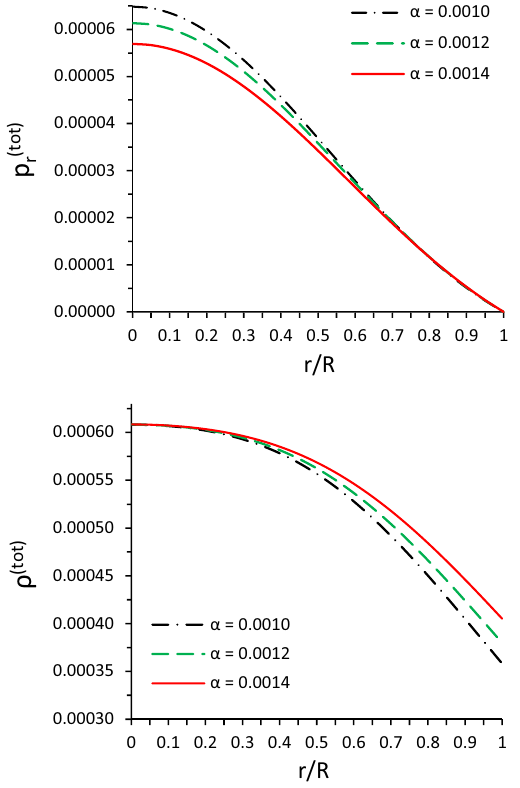
Fig. 2 The behavior of total radial pressure p tot r (top left), total tangen- tial pressure p tot t (top right), total energy density ρ tot r (bottom left), and anisotropy factor (cid:14) (bottom right) verses radial coordinate r / R . The